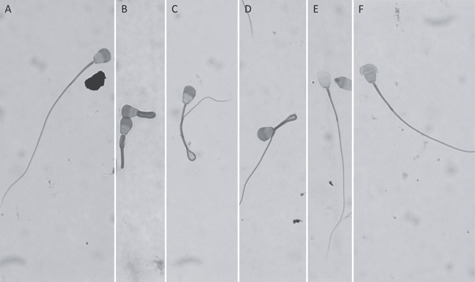
Morphological assessment of sperm stained with Spermac® showing normal and predominant abnormalities observed. (A) normal, (B) coiled tail, (C) bent tail, (D) bent mid-piece, (E) absent acrosome, (F) damaged acrosome.